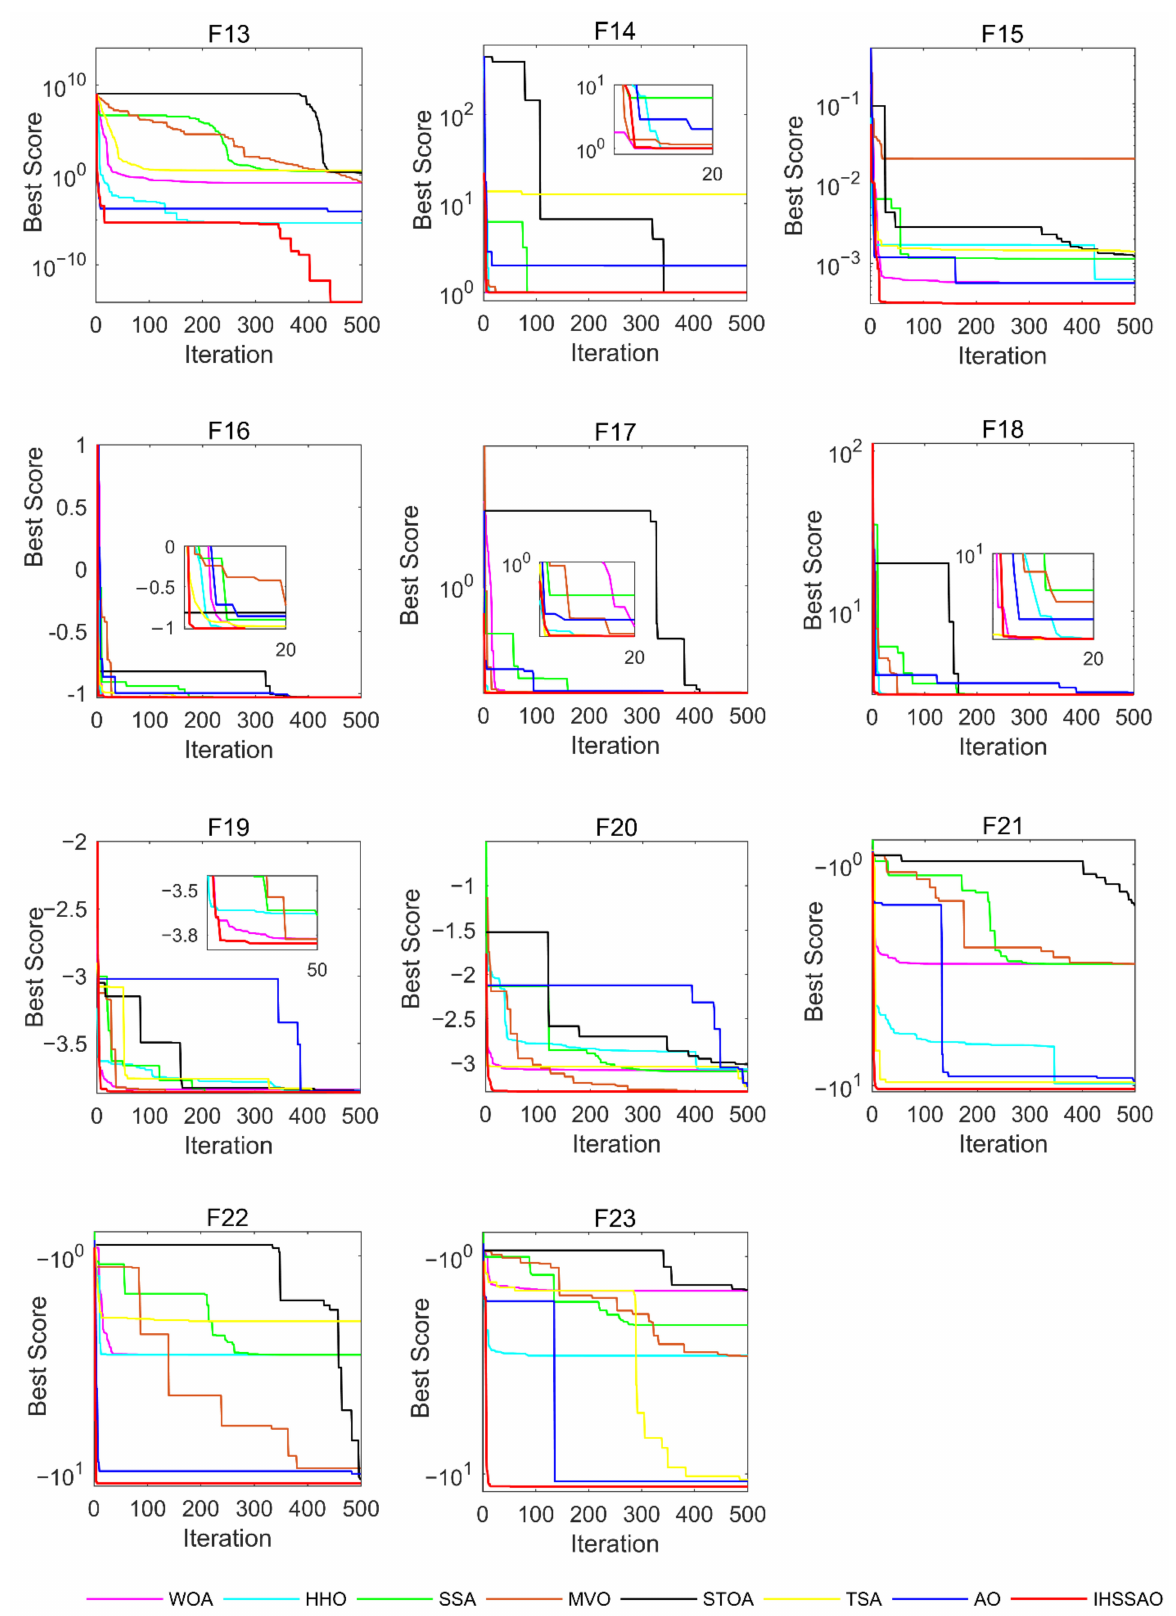
Figure 7. Convergence curve of IHSSAO and other different algorithms on 23 benchmark